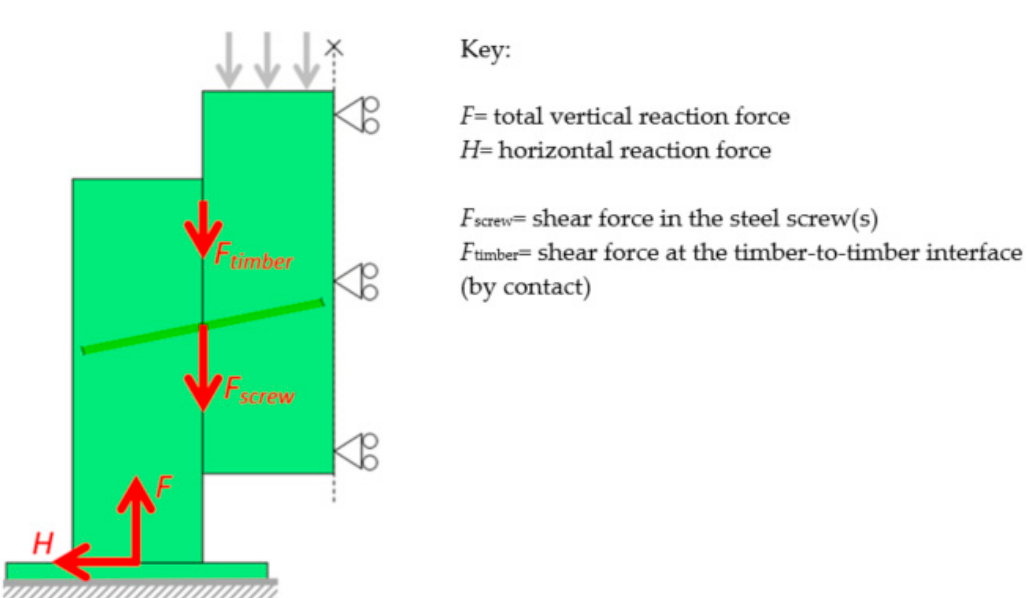
Figure 7. Monitored force contributions for the mechanical analysis and characterization of TTC joints with inclined STSs under a standard PO setup.